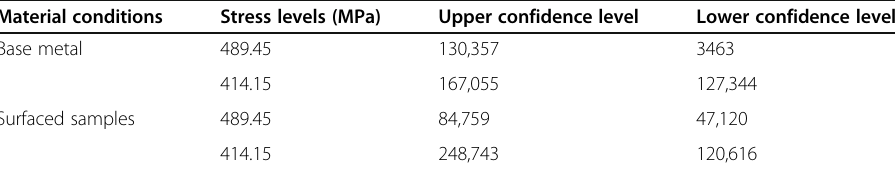
Table 6 Confidence intervals for each stress level used for both base metal and surfaced samples Material